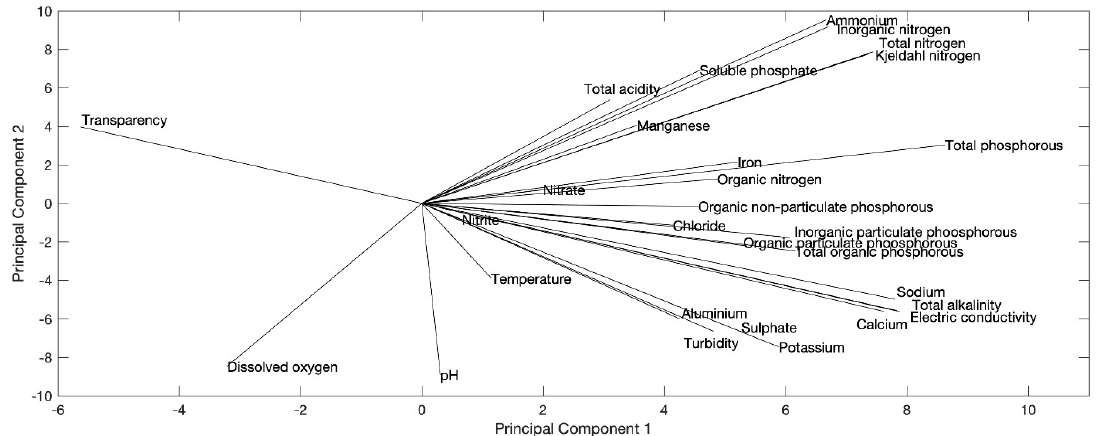
Figure 6. Representation of the main components of the PCA model applied to the physicochemical data set (descriptor graph).